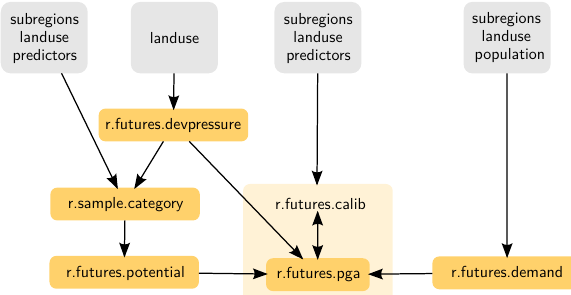
Figure 2: Diagram of FUTURES workflow showing how are r.futures modules (yellow boxes) chained and what are their input data (grey boxes). As indicated by the light yellow box, module r.futures.calib calls r.futures.pga .